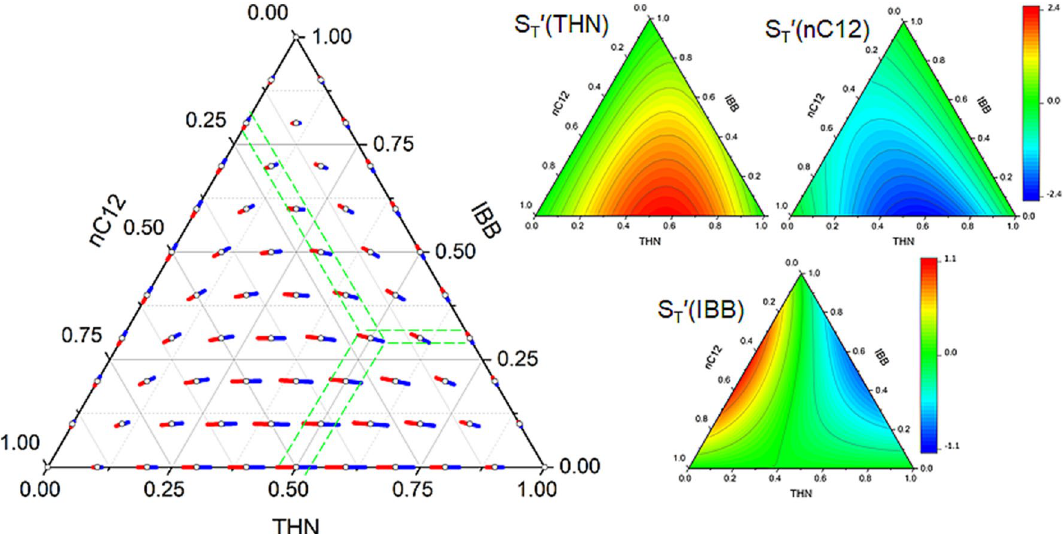
Figure 3. The Soret vector field in the THN–IBB–nC12 ternary mixture offering a valuable overview of the entire Soret separation. The green lines illustrate the setting up the vector projections on the axes. The colored triangles on the right hand side present the distribution of the S ′ T (THN), S ′ T (IBB), and S ′ T (nC12) over the composition space according to Ref. 26 . The color scale for S ′ T (THN), S ′ T (nC12) is the same and for S ′ T (IBB) is halved.